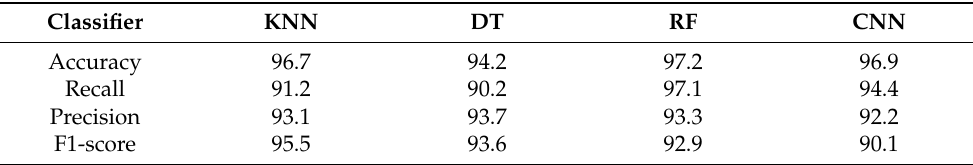
Table 5. Phase 1: Continuous authentication results for Scenario C: set of mouse movement and point-and-click